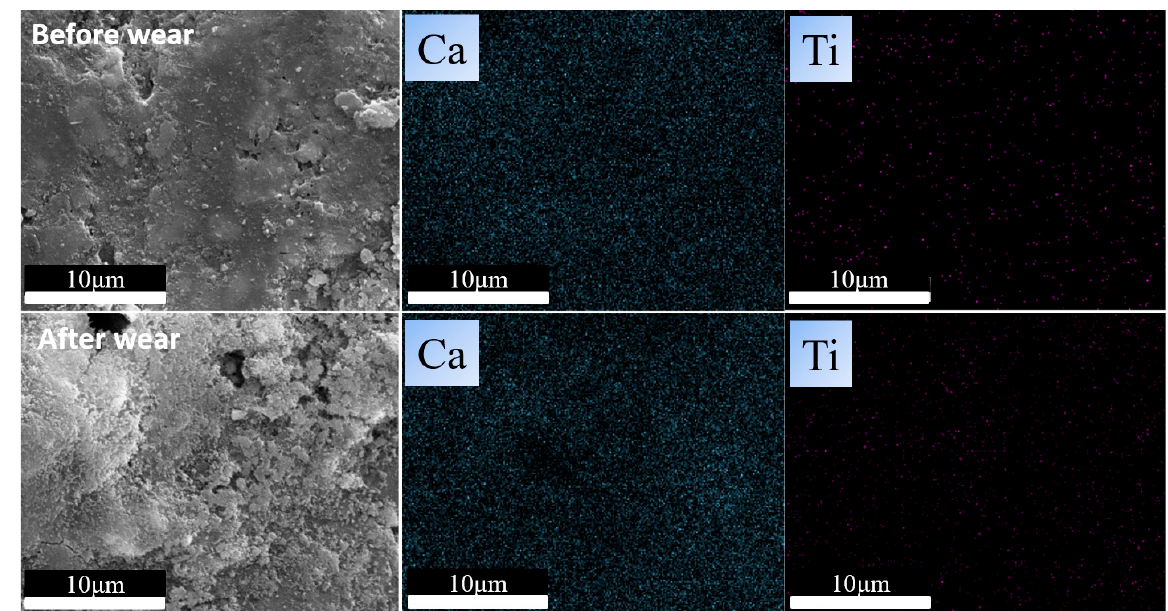
Figure 8. Elemental distribution of Ti and Ca on CM-S mortar surface before and after wearing.